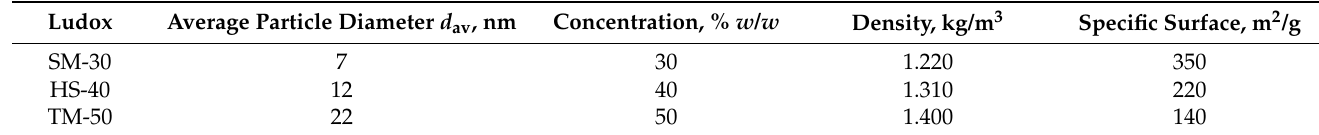
Table 1. Parameters of Ludox